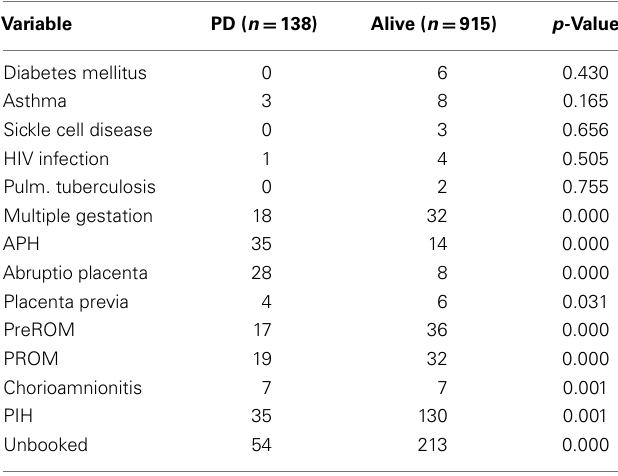
Table 3 | Maternal antenatal variables association with perinatal death